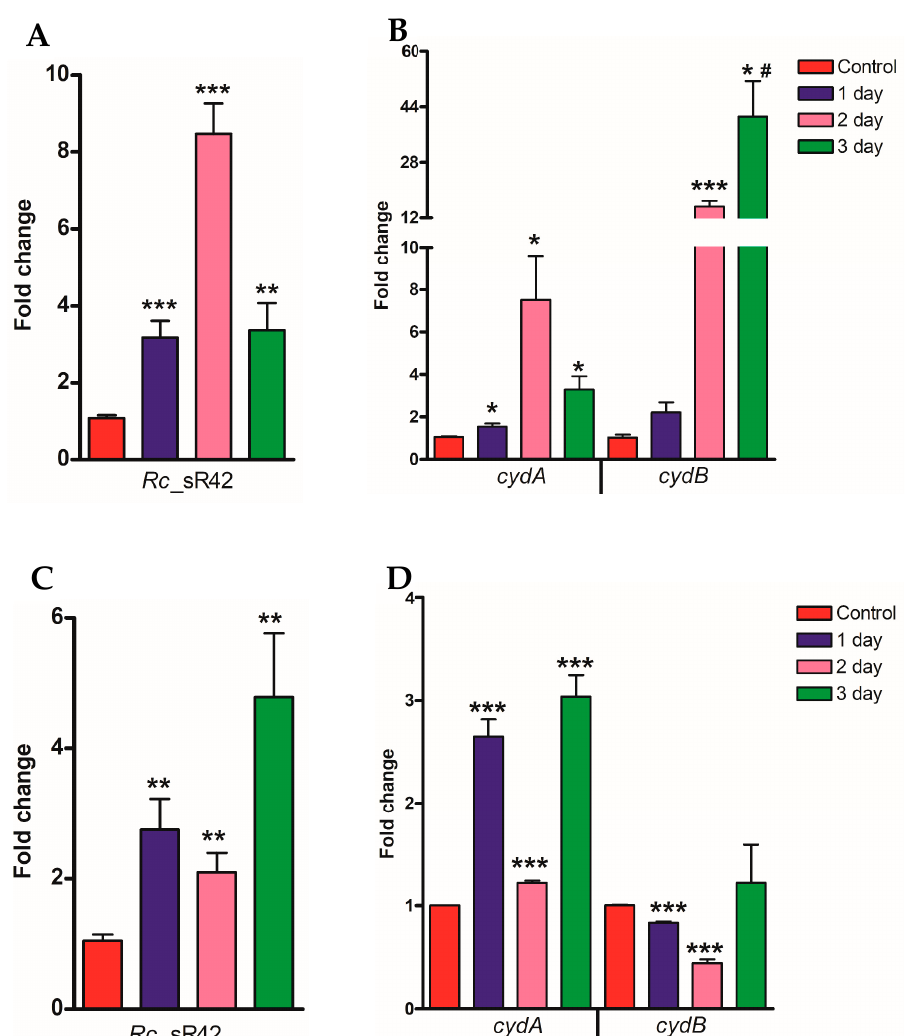
Figure 2. Expression profile of Rc _sR42 sRNA ( A , C ), cydA and cydB coding transcripts ( B , D ) in R. conorii during the infection of mouse lung ( A , B ) and brain ( C , D ) tissues in vivo. Significant changes in the expression of both coding ( cydA and cydB ) and non-coding ( Rc _sR42) transcripts were observed at days 1–3 post-infection compared to the control. # Denotes significant changes ( p < 0.05) observed between 3 h vs. 24 h and 3 h vs. 48 h. * p < 0.05, ** p < 0.005, *** p < 0.001.